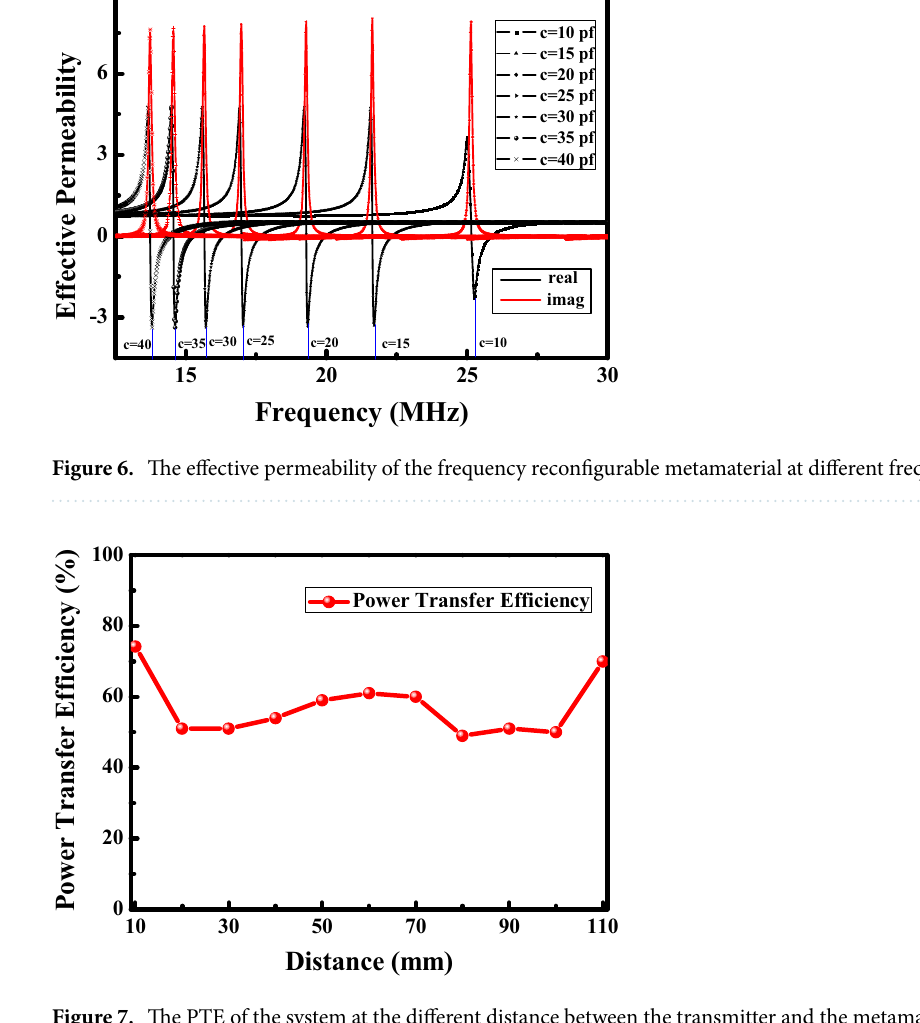
Figure 7. The PTE of the system at the different distance between the transmitter and the